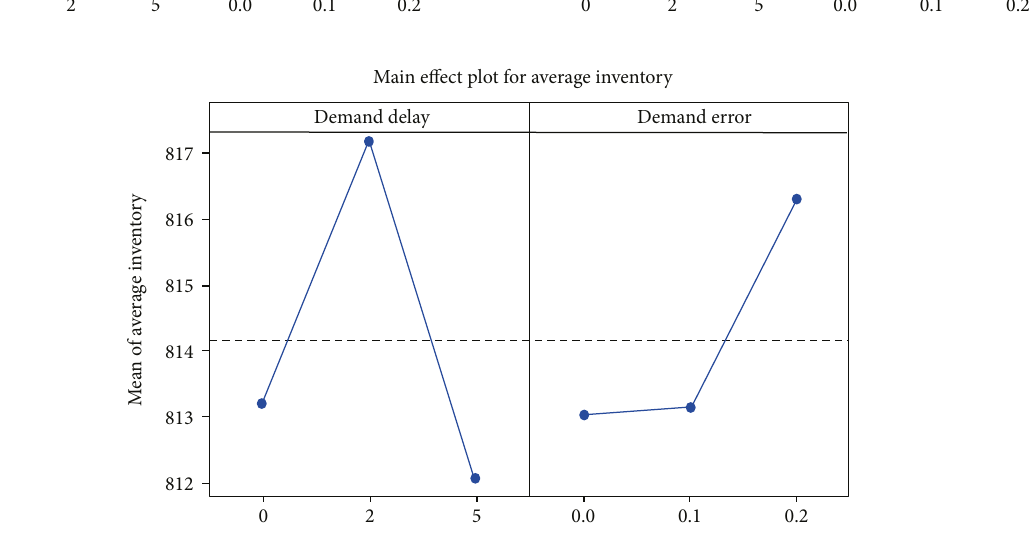
Figure 1: Main e ff ect